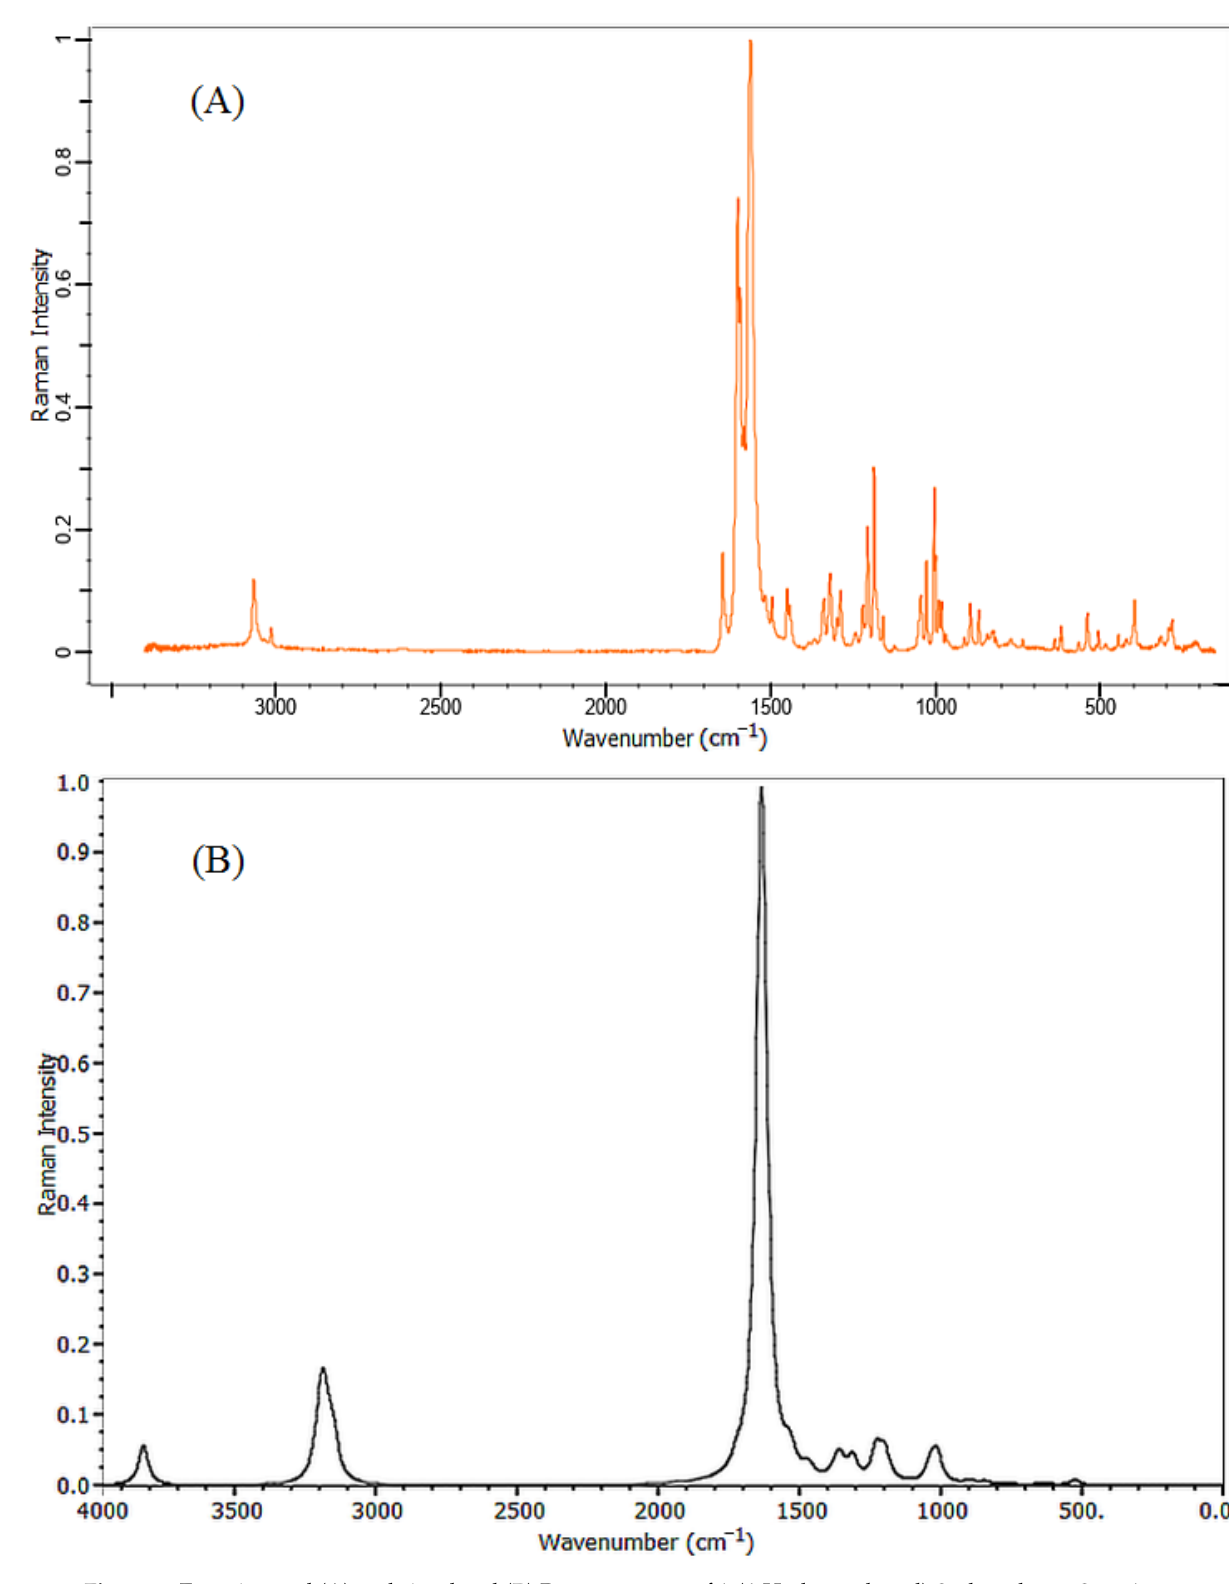
Figure 3. Experimental ( A ) and simulated ( B ) Raman spectra of 1-(4-Hydroxyphenyl)-3-phenylprop-2-en-1-one.